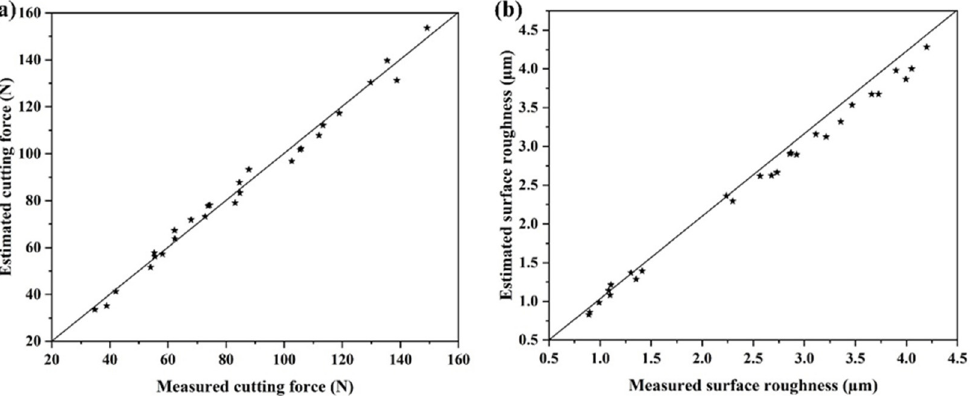
Figure 5. Experimental and regression-estimated response for ( a ) cutting force and ( b ) surface roughness of the RZ5/8 wt.% TiB 2 composite.